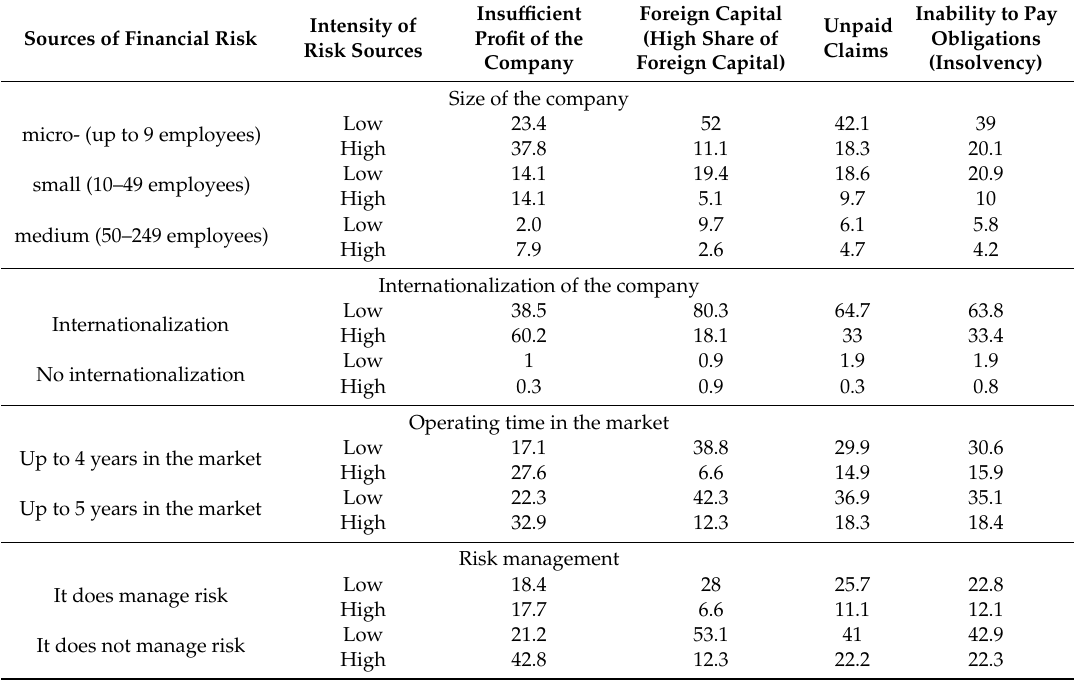
Table 1. The percentage of intensity of financial risk depending on the model